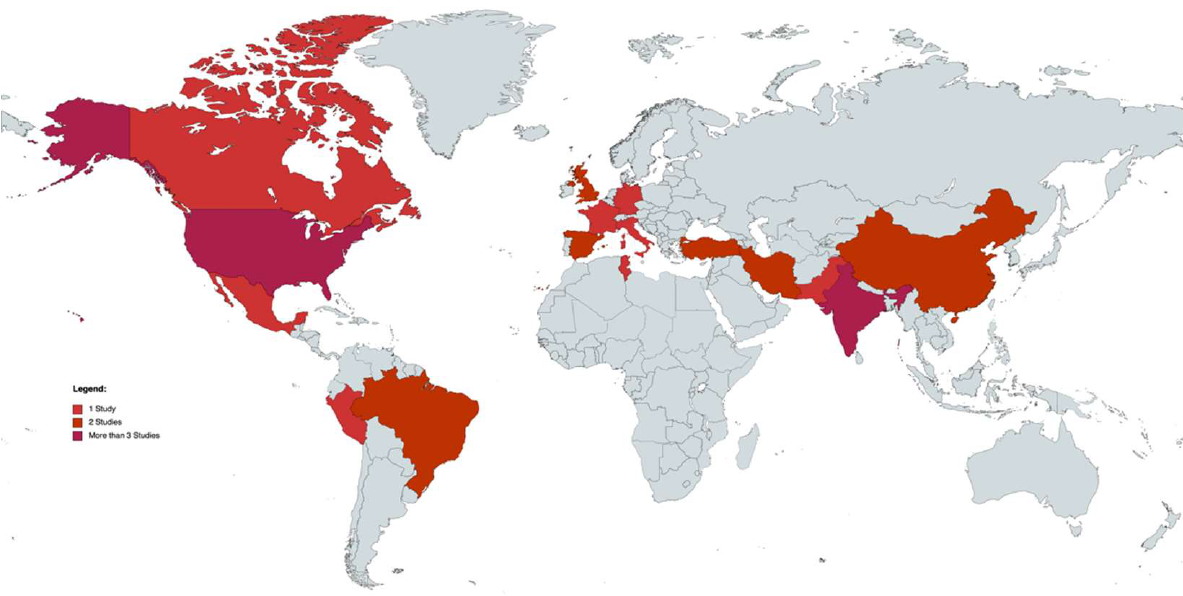
Figure 2. World map of studies included. Map generated through MapChart (MapChart, 2021).